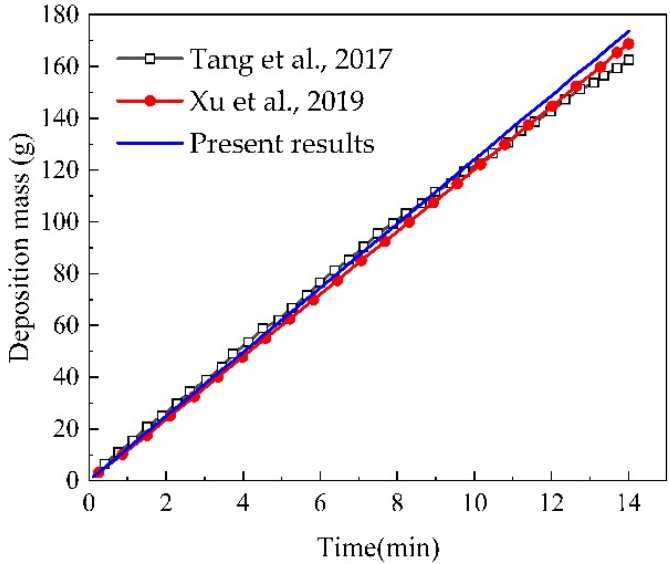
Figure 10. Mass verification results of particle deposition [4,6].